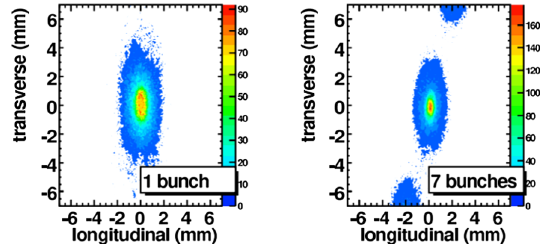
FIG. 3. Top view of 1 mA bunch distributions at the turn 130 in the local frame in the PSI ring cyclotron. The results are obtained from single bunch (left) and seven bunches (right) simulations